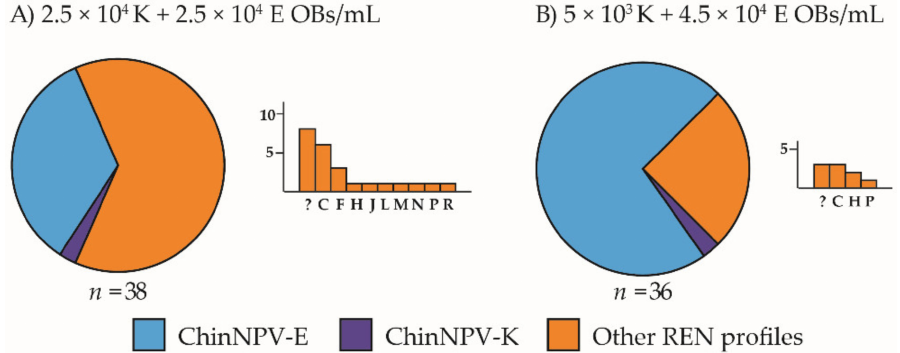
Figure 4. Prevalence of ChinNPV-K and ChinNPV-E REN profiles in Chrysodeixis includens fifth instar larvae that died following inoculation with variant mixtures (K + E) at low inoculum concentra- tion (total concentration 5 × 10 4 OBs/mL). Inocula were ( A ) 2.5 × 10 4 K + 2.5 × 10 4 E OBs/mL, ( B ) 5 × 10 3 K + 4.5 × 10 4 E OBs/mL. Circular charts represent the proportions of REN profiles of ChinNPV-E, ChinNPV-K and other variants recovered from dead larvae. A bar chart depicted next to each circular chart indicates which REN profiles were recovered among the other variants and their frequency. The y -axis indicates the number of insects that showed a particular dominant REN profile in the progeny OBs and the x -axis indicates each of the REN profiles observed in descending fre- quency; n indicates the number of insects analyzed. Novel REN profiles were classified as unknown and are shown as “?” in bar